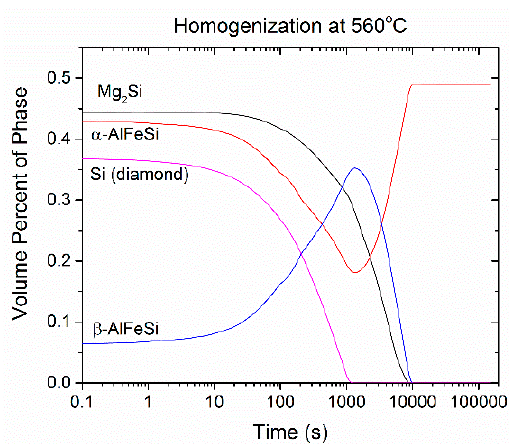
Figure 5. Temporal evolution of volume percent of Mg 2 Si, α -AlFeSi, β -AlFeSi and Si (diamond) during homogenization at 560 °C in 6082 alloy.